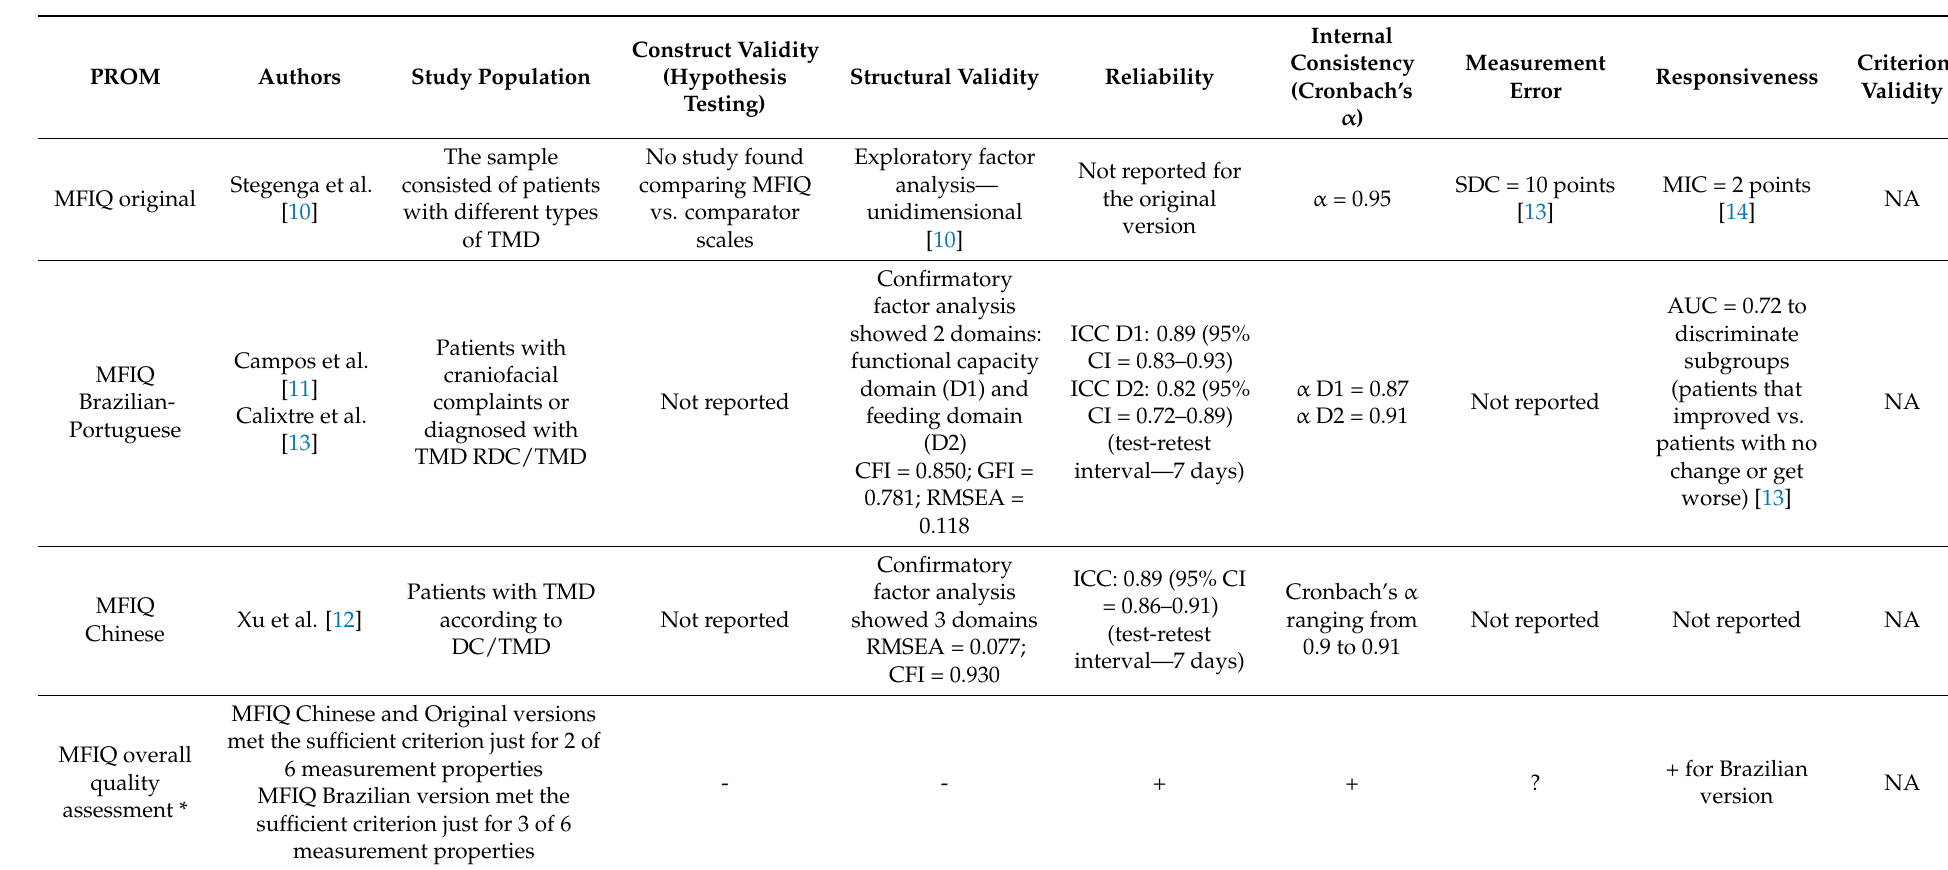
Table 1. Summary of the measurement properties of Mandibular Function Impairment Questionnaire (MFIQ)